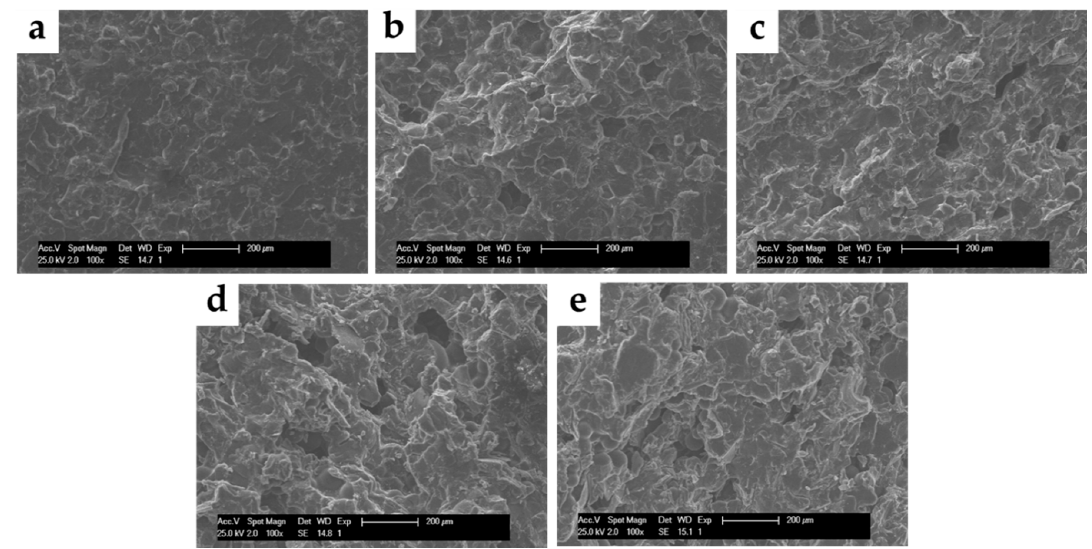
Figure 4. SEM micrographs (100×) of surfaces of ABCs loaded with CS. a ) ABC 0% CS, b ) ABC 5% CS, c ) ABC 10% CS, d ) ABC 15% CS, and e ) ABC 20% CS.